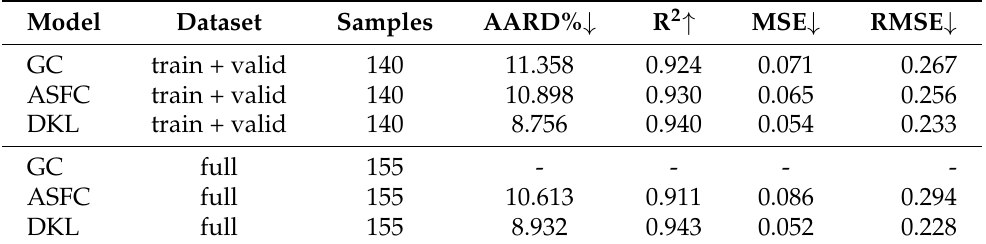
Table 2. Performance comparison of our DKL model with existing models on the training, validation, and full